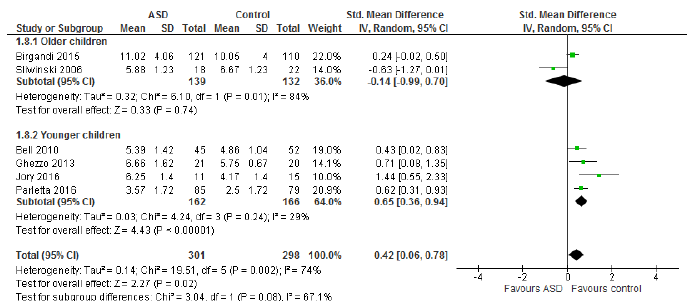
Figure 5. Forest plot of mean (95% confidence interval (CI)) weighted difference in the ratio of total n ‐ 6 long chain polyunsaturated fatty acids ( n ‐ 6 LCPUFA) to total n ‐ 3 long chain polyunsaturated fatty acids ( n ‐ 3 LCPUFA) between populations with Autism Spectrum Disorder (ASD) and typically developing children stratified for subgroups with studies including all age groups (children, teenagers, and adults) vs. young children only. Direction of effect (negative, lower mean in ASD group; positive, lower mean in control group; zero, no difference between groups).